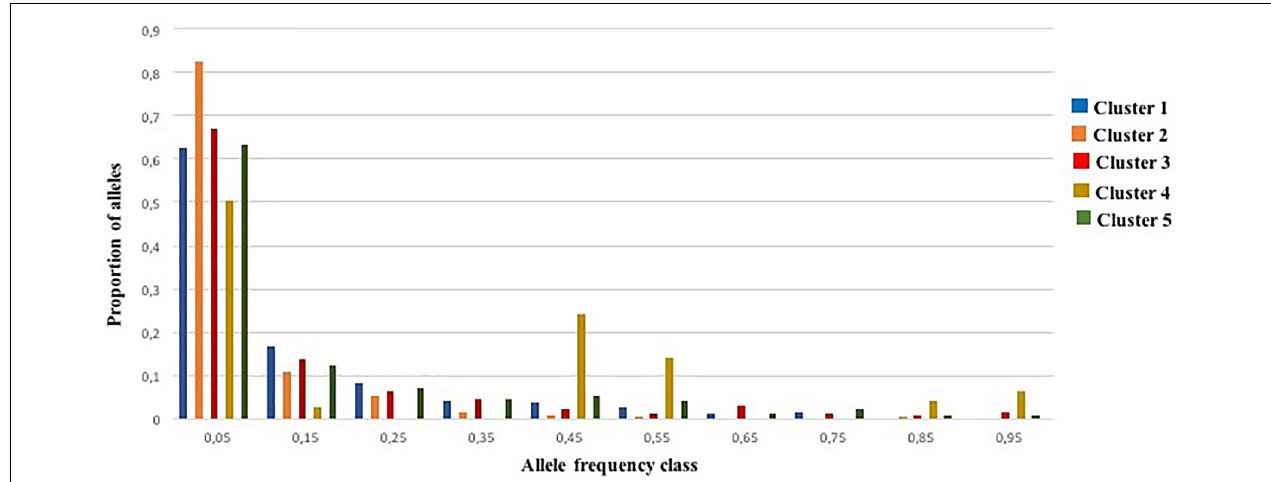
FIGURE 5 | Allele frequency distribution for 25 SSR loci within the five genetic clusters. Bars represent the proportion of alleles found in each allele frequency class. The distribution is L-shaped, as expected for a stable population under mutation-drift